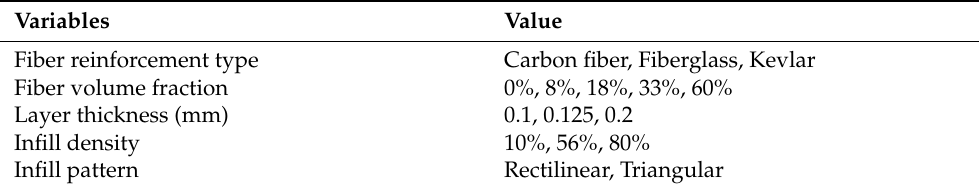
Table 1. Variables and their